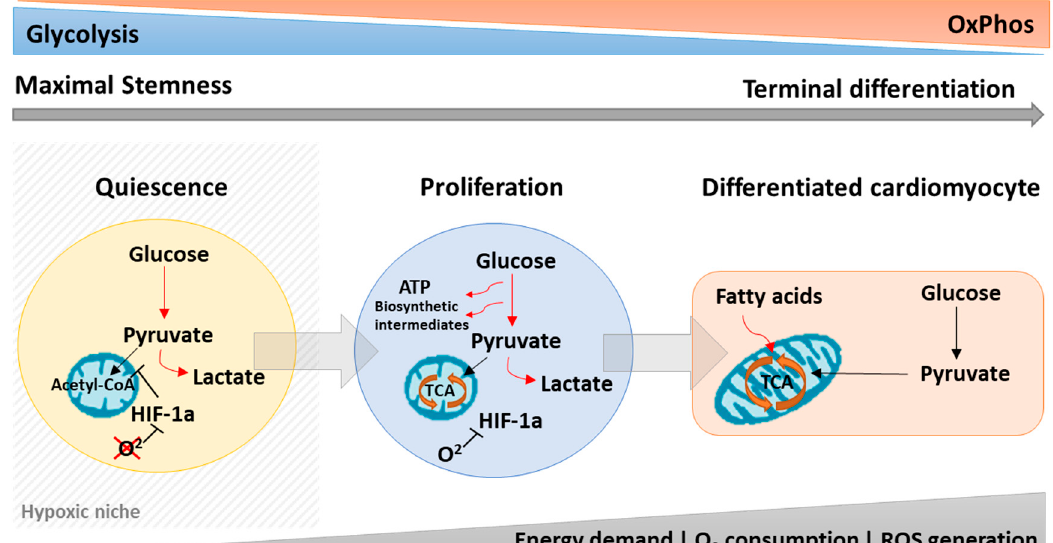
Figure 1. Stem cell metabolism is dynamically modulated to control stemness, proliferation, and cell commitment. Quiescent stem cells are mostly glycolytic due to HIF-1 α activity in the hypoxic niche with low generation of ROS to maintain stemness. Outside the hypoxic niche, the oxygen levels begin to rise increasing the oxidative phosphorylation (OxPhos) and reactive oxygen species (ROS) levels, which stimulate the cells to proliferate and differentiate. During proliferation, stem cells mainly rely on glycolysis while still maintaining low OxPhos levels to fuel the cells with biosynthetic intermediates important for cell growth. Stem cell differentiation to cardiomyocytes, however, depends on a metabolic shift from glycolysis to OxPhos in a ROS-dependent manner.